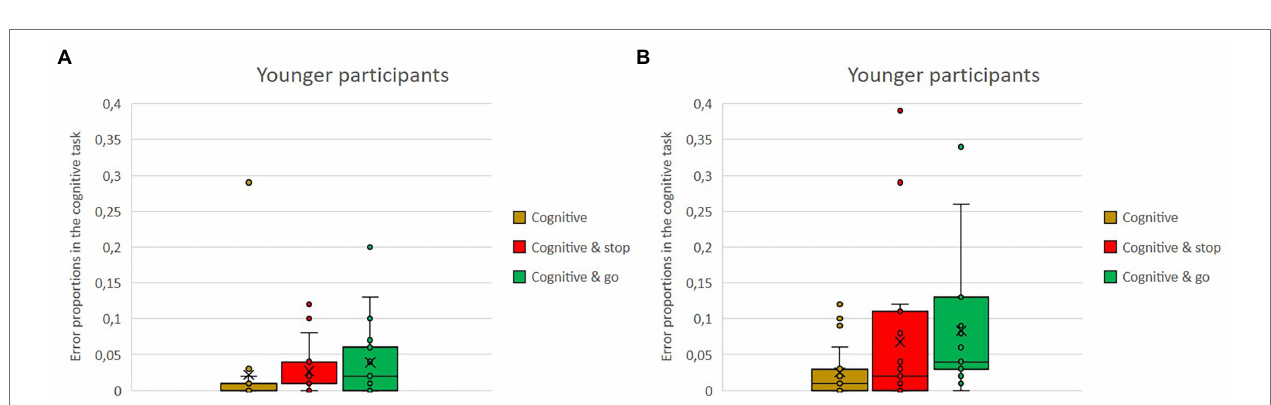
FIGURE 8 | (A,B) Means of error proportion in the visual secondary task, as single vs. dual-task conditions either the stop or the go task for the older and the younger